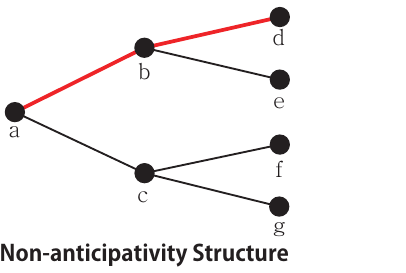
Figure 1. Convergence strategy comparison between progressive hedging ( left ) and proximal bundle ( right